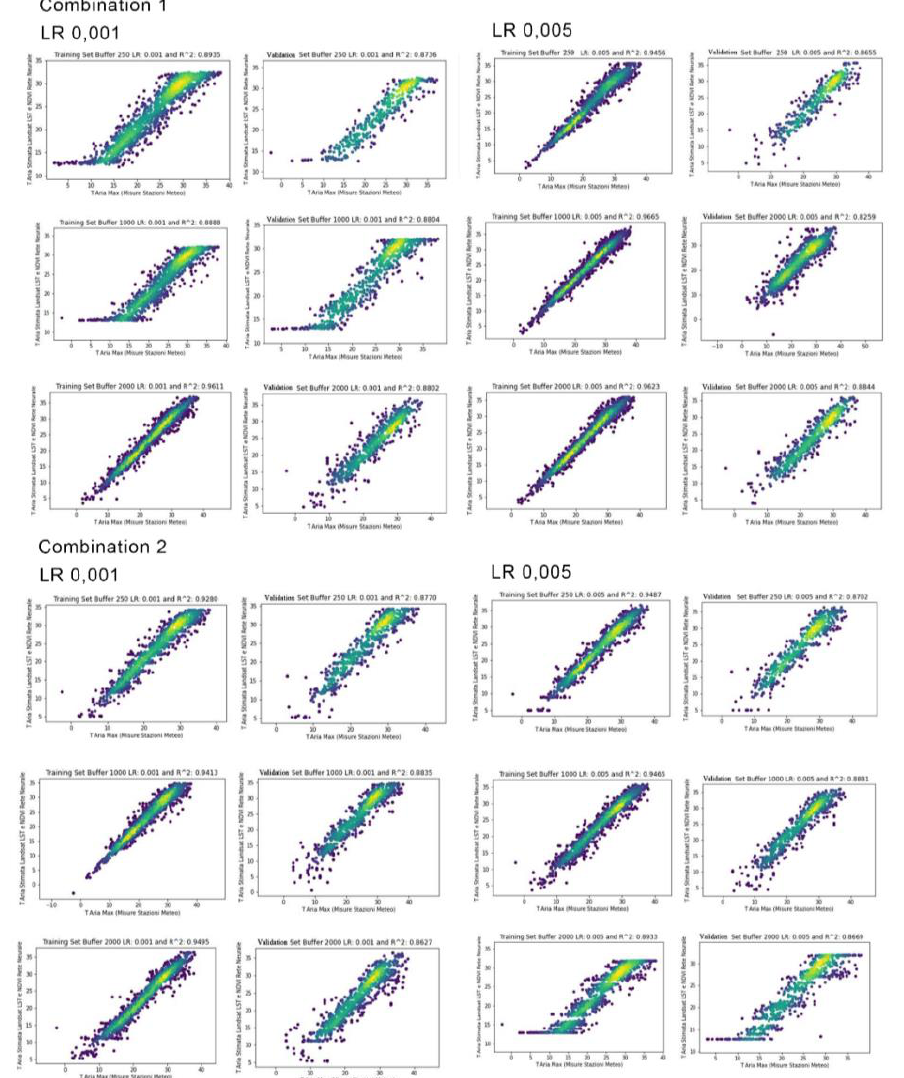
Fig. 7: Scatter plots estimated vs reference max air temperature with LR=0.001 (left column training, right column validation) – data combination 1 and data combination